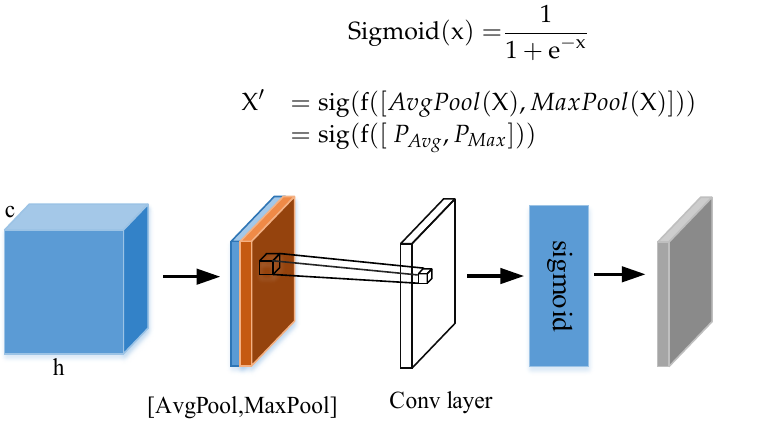
Figure 4. Spatial Attention Module. (Reprinted with permission from Ref. [30]. 2018, Sanghyun Woo, Jongchan Park, Joon-Young Lee, In So Kweon).